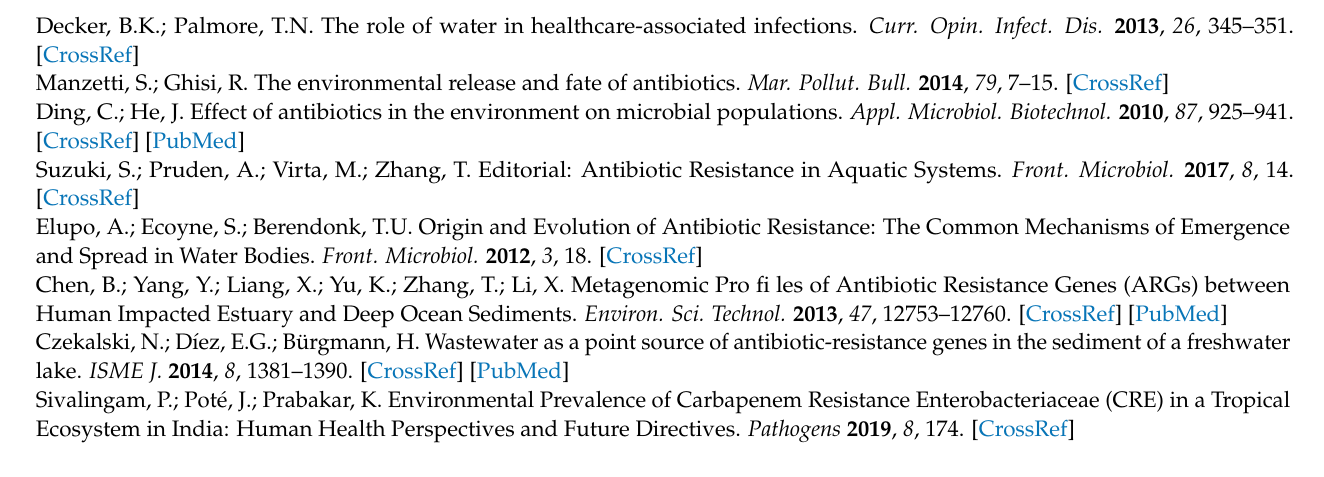
Figure S1: Articles x